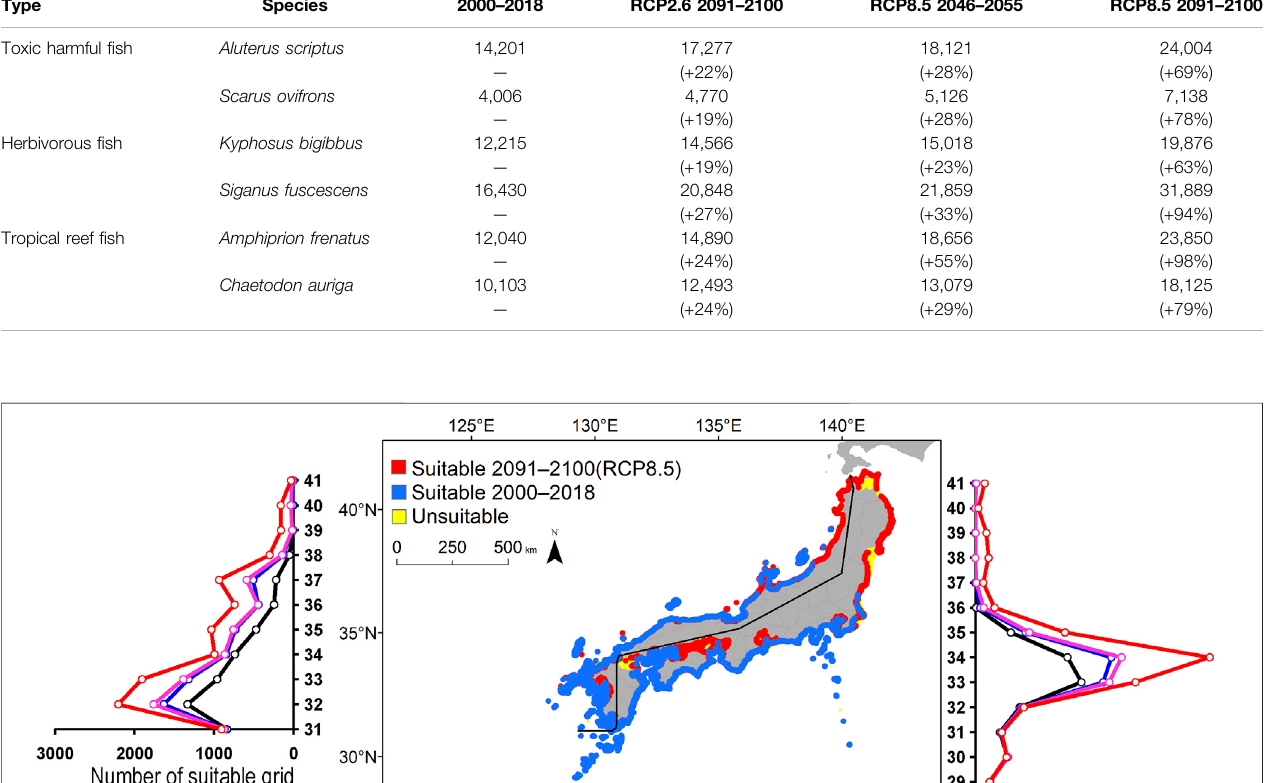
Frontiers in Built Environment |